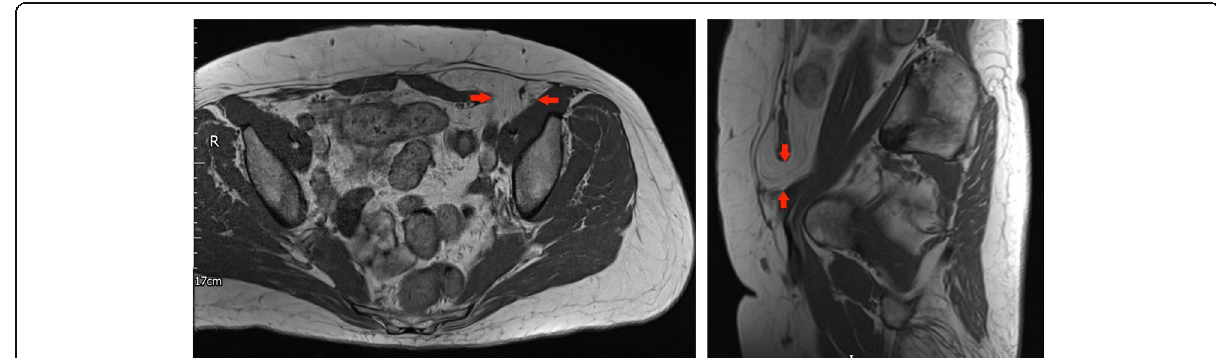
Fig. 6 Left panel: Axial T1-weighted MRI of the pelvis and lower abdomen: red arrows outline a defect in the linea semilunaris with a fat containing hernial sac. Right panel: Sagittal T1-weighted MRI of the pelvis and lower abdomen: Spigelian hernia outlined by red arrows with hernial sac extending to the level of the pubic symphysis